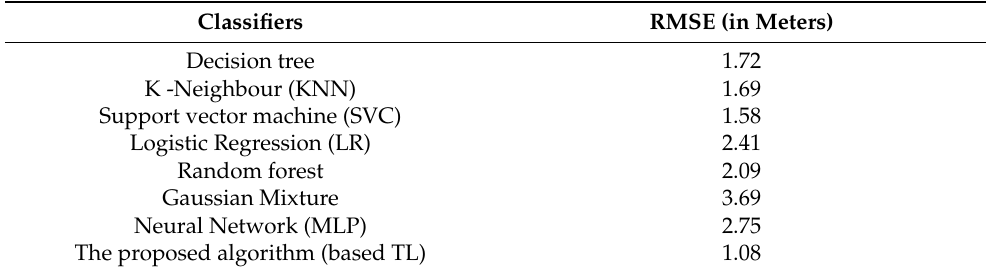
Table 7. Models’ target prediction using the new feature spaces of 41 Wi-Fi access points based OHetTLAL.